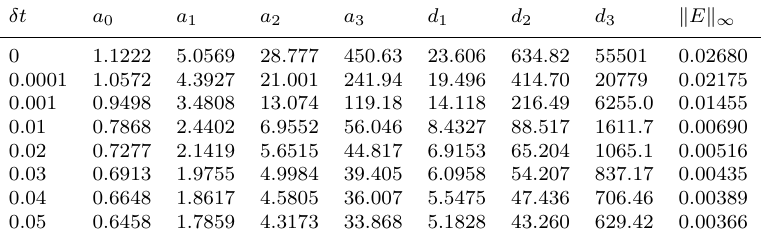
Table 3. Objective function (3.5), coefficients and errors for Example 1 are computed for different values of